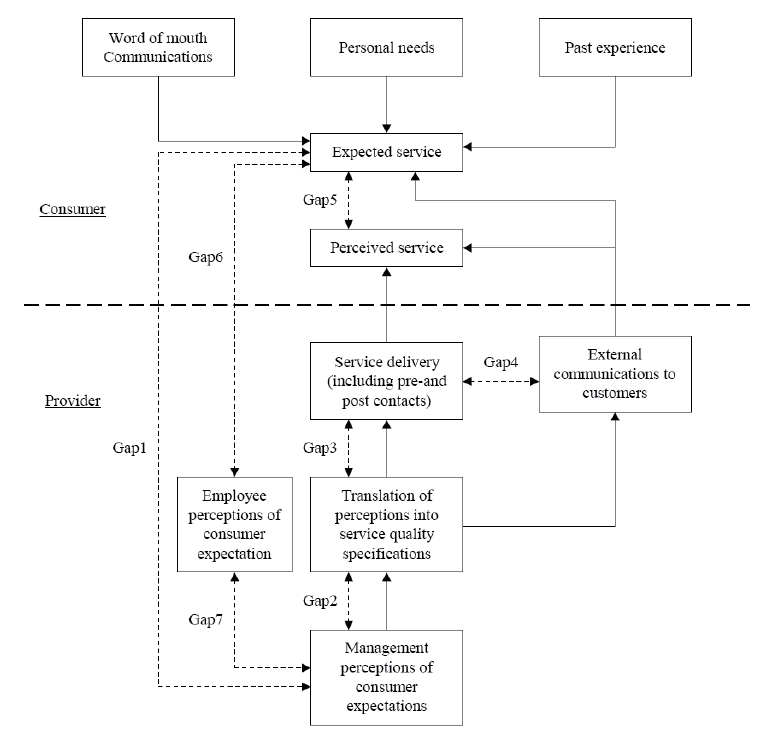
Fig. 1 – A conceptual model of service quality. Source: Parasuraman et al, 1985.